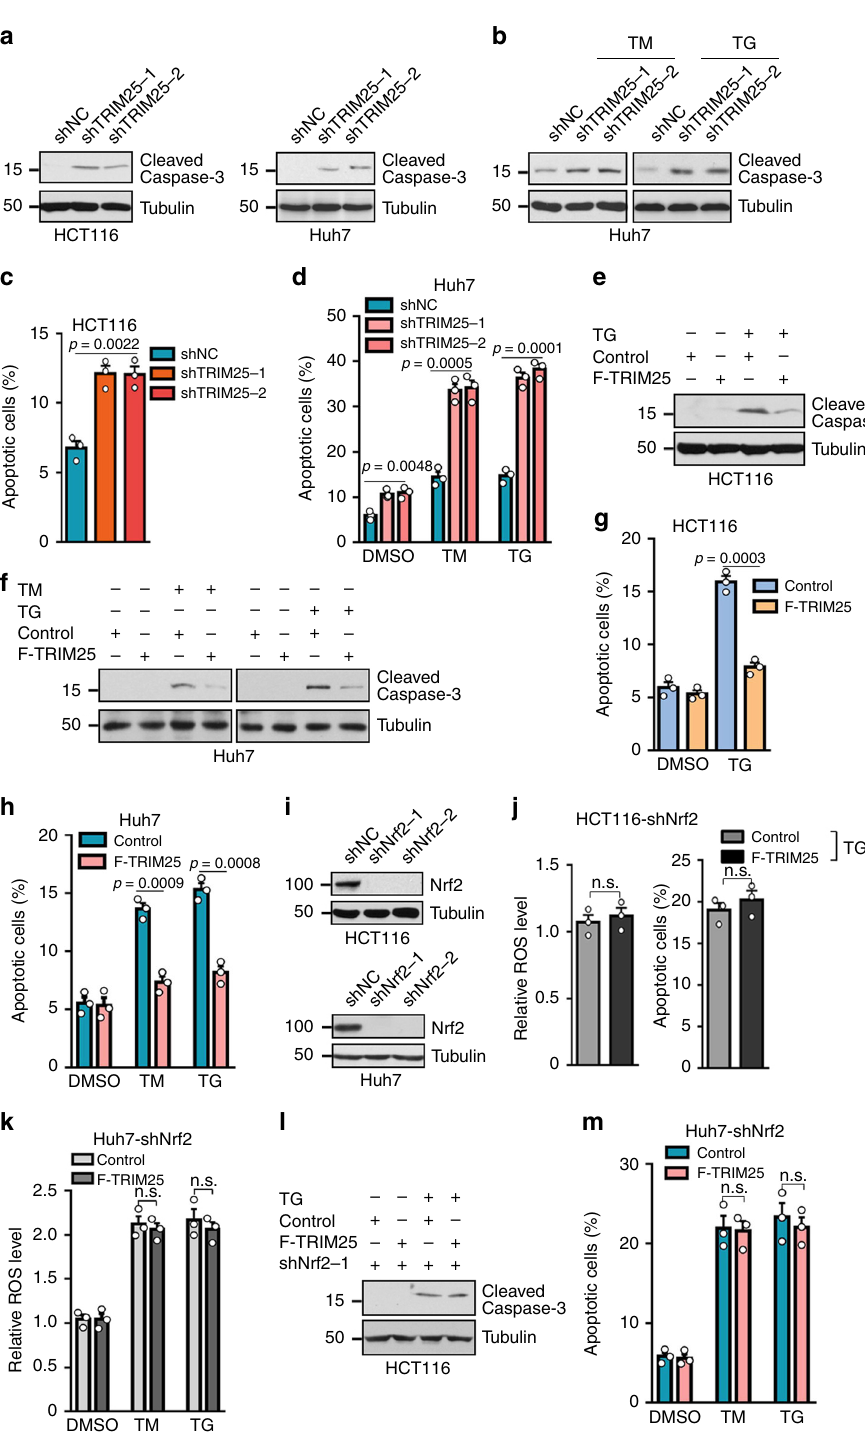
TRIM25 ampli fi cation displayed shortened